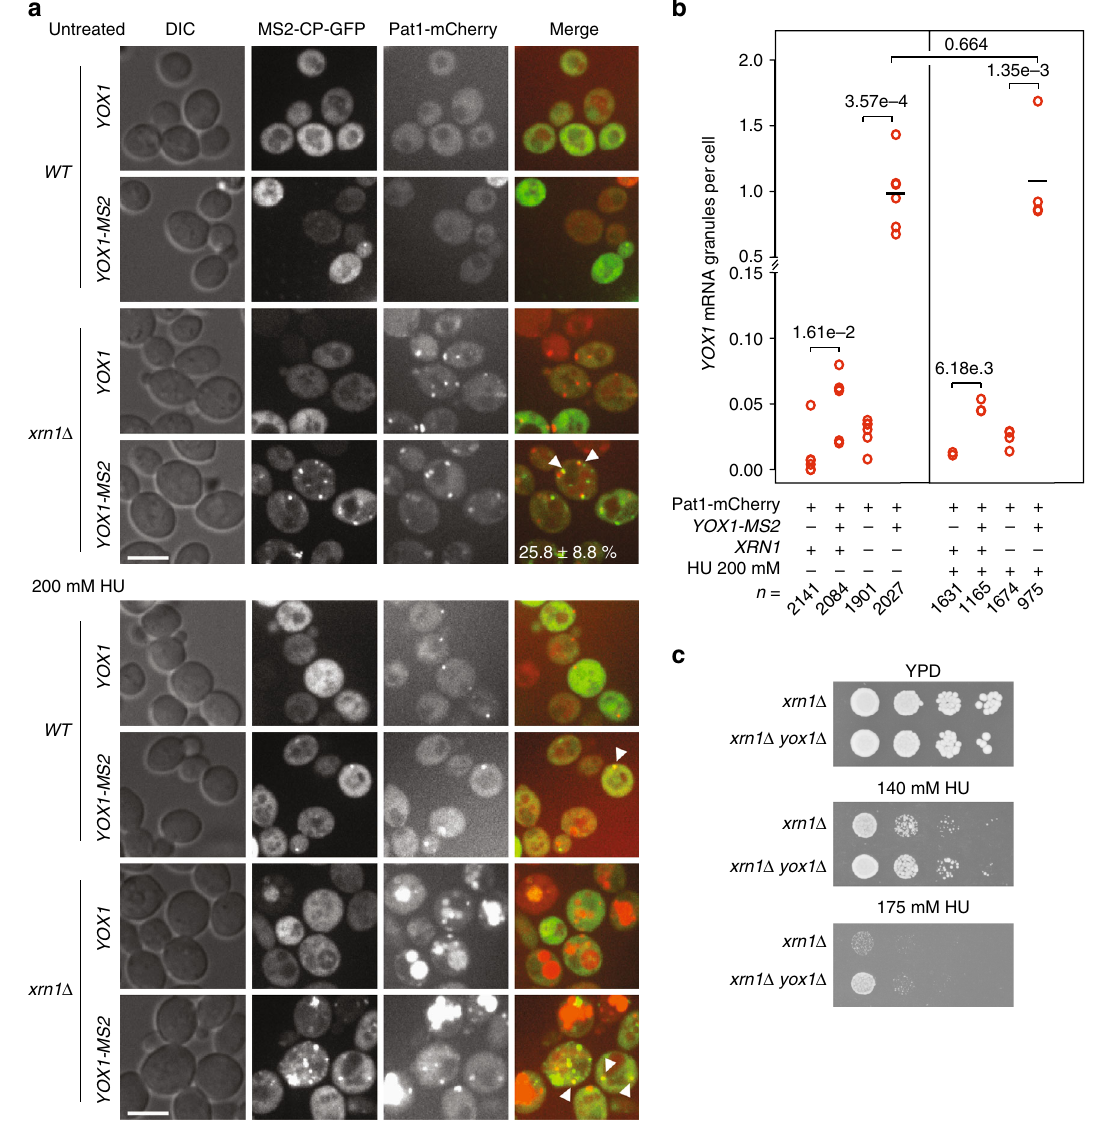
Fig. 4 YOX1 mRNA forms cytoplasmic granules and accumulates at P-bodies. a Representative images of cells co-expressing MS2-CP-GFP and Pat1-mCherry, with or without YOX1 tagged with MS2 repeats, before and after 2 h of treatment with HU. Cytoplasmic granules were assessed in both WT and in xrn1 Δ cells. Scale bars are 7 µ m. Arrows indicate YOX1 mRNA granules that co-localize with Pat1-mCherry granules. b Quanti fi cation of YOX1 mRNA granules in untreated and HU-treated cells. The average number of foci per cell is plotted for each of at least three replicates. The solid bar indicates the average of the replicates, P -values are from Student ’ s t -tests, and n indicates the total number of cells examined. c Serial 10-fold dilutions of the indicated strains were spotted on YPD with or without HU. Plates were imaged after 3 – 4 days of growth to test the suppression of yox1 Δ HU sensitivity by deletion of